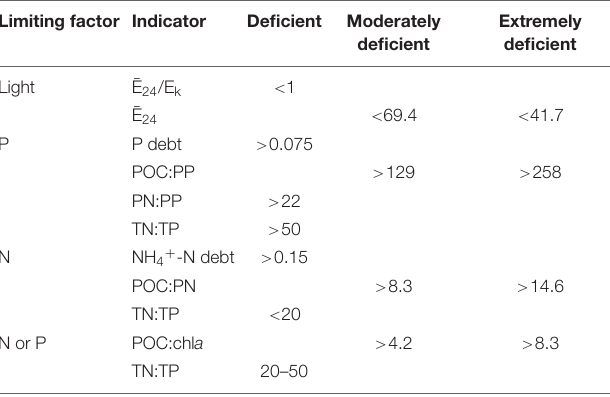
TABLE 2 | Established light and nutrient status indicator thresholds that were applied to the reservoir phytoplankton communities to assess deficiency. Limiting factor